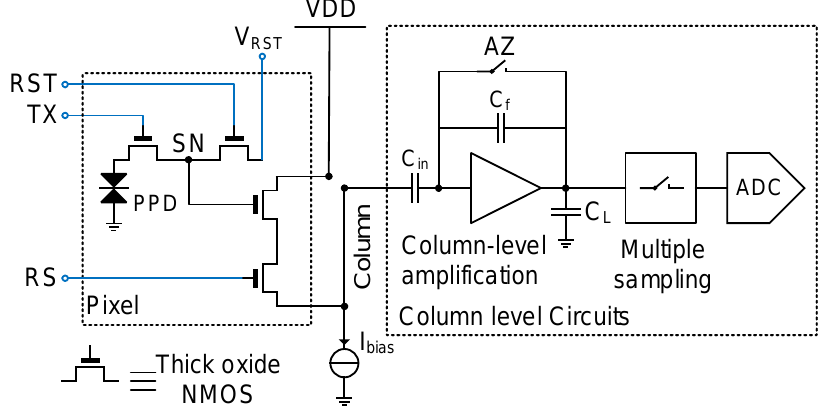
Figure 1. Schematic of a conventional low noise CMOS image sensor (CIS) readout chain. RST, reset switch; TX, transfer gate; RS, row selection switch; SN, sense node; PPD, pinned photodiode; AZ, auto-zero; VDD, supply voltage